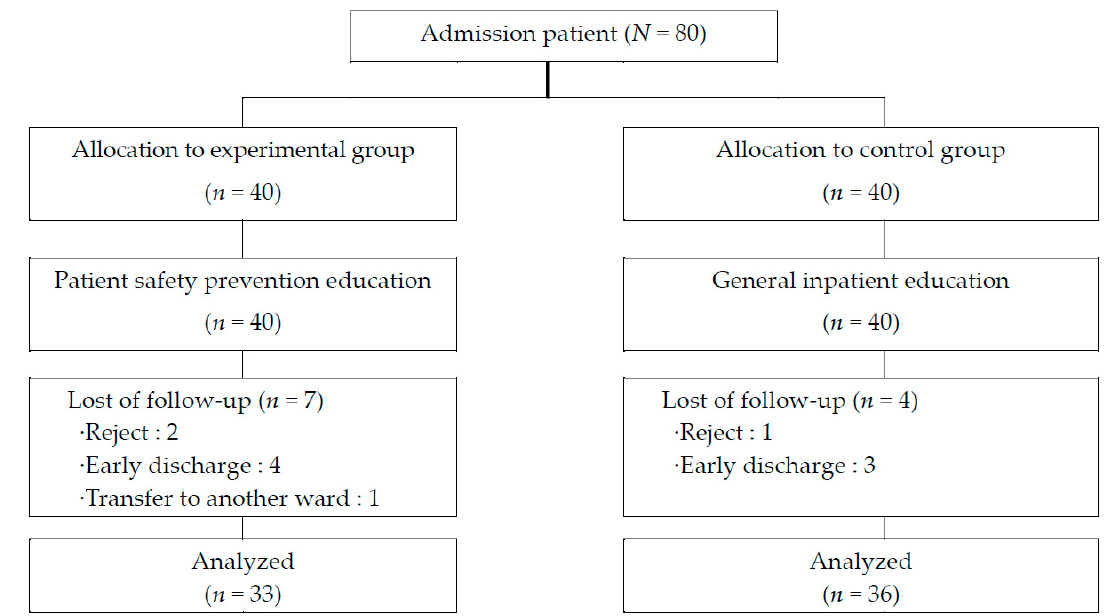
Figure 2. Flow diagram of study participants.